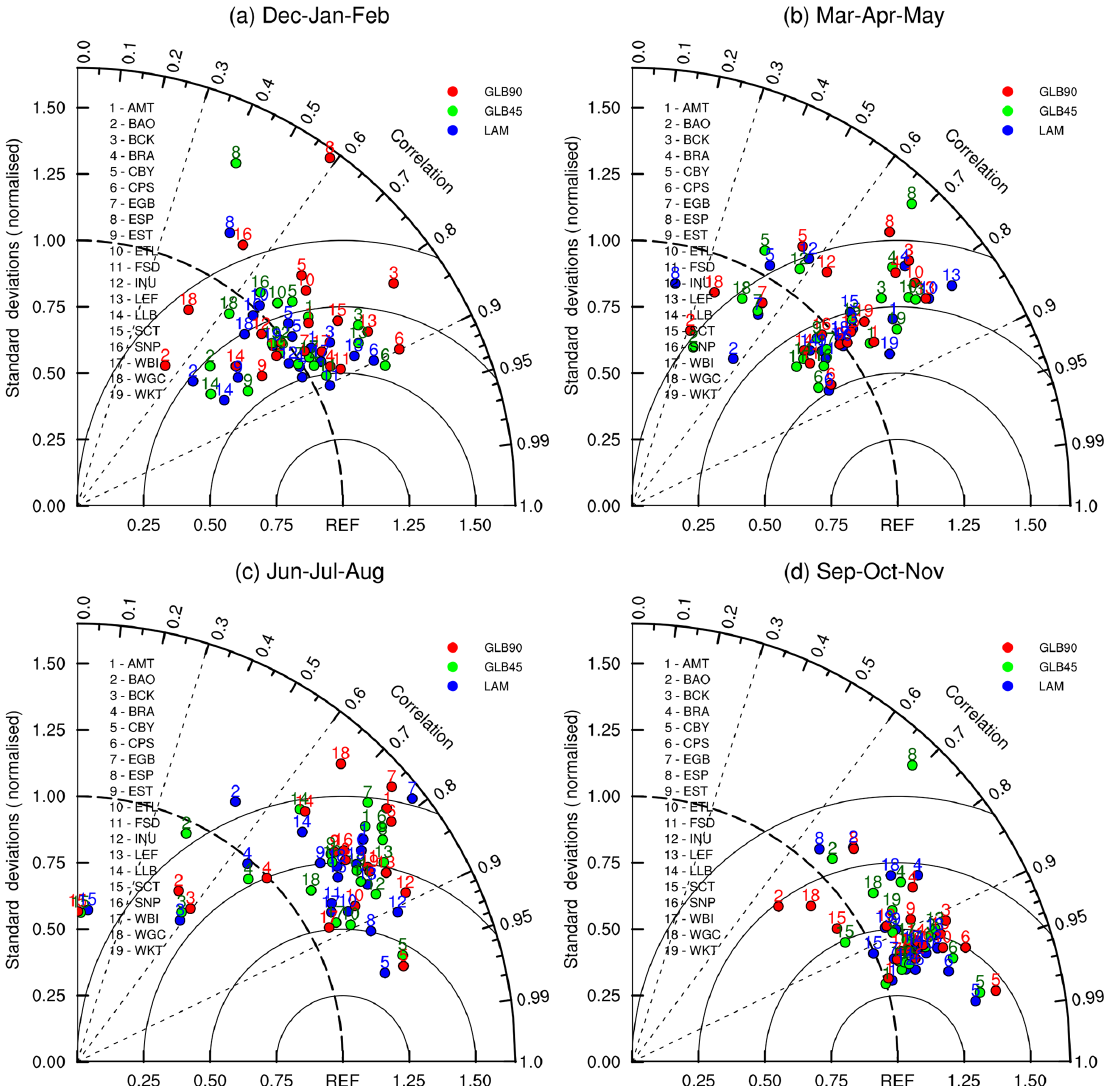
Figure 12. Taylor diagram showing correlations and normalised standard deviations between daily afternoon modelled CO 2 concentrations and observed CO 2 concentrations from three models, GLB90 (red), GLB45 (green) and LAM (blue), over (a) January to February and December 2015, (b) March to May 2015, (c) June to August 2015, and (d) September to November